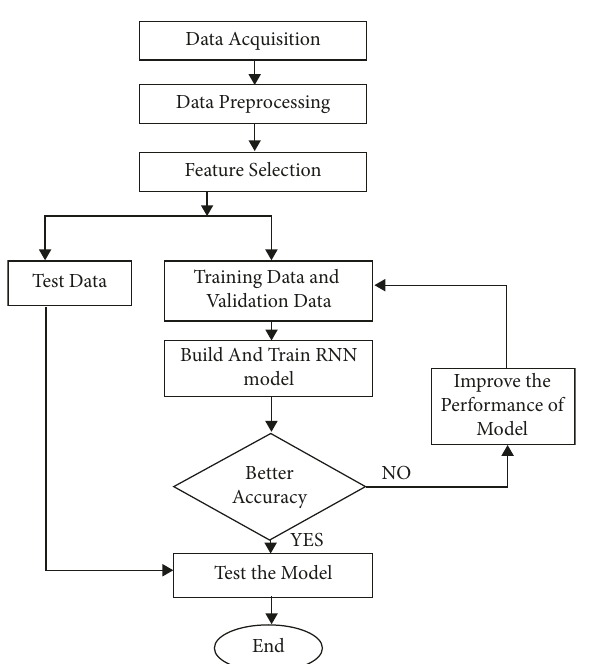
Figure 5: Schematic block of the AI-based training and prediction